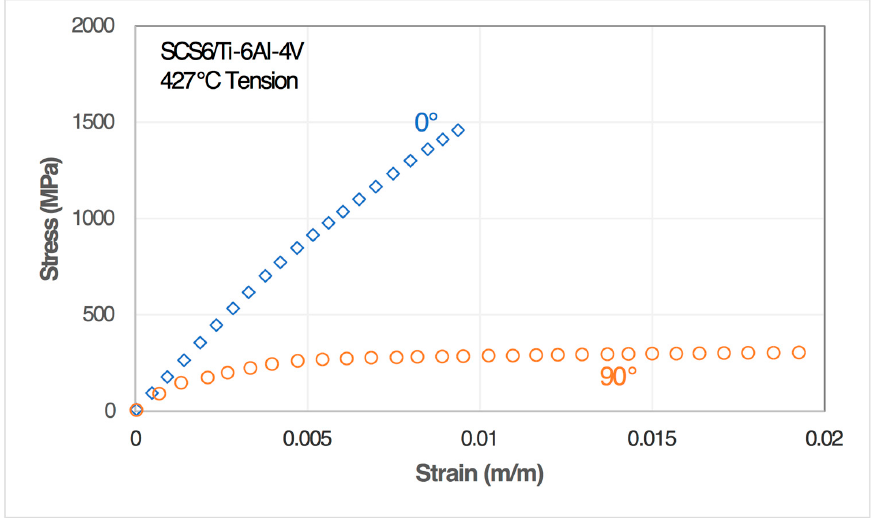
Figure 4. Tensile test data of unidirectional SCS-6/Ti-6Al-4V composite for 0° and 90° loadings at 23 °C.